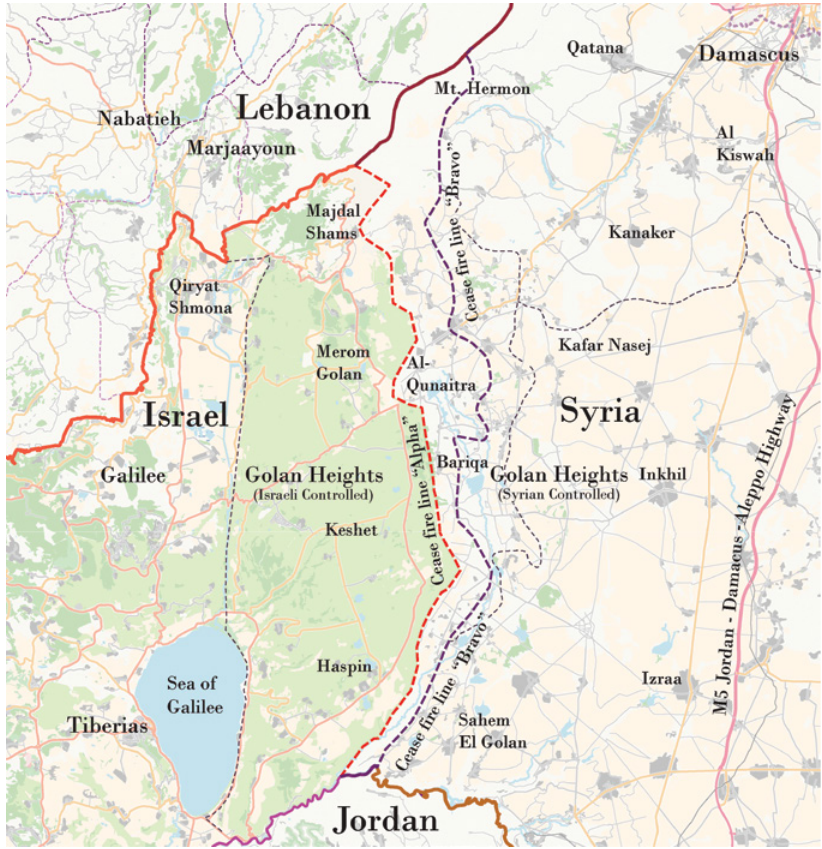
Figure 2. Map by Maier Yagod based on © OpenStreetMap